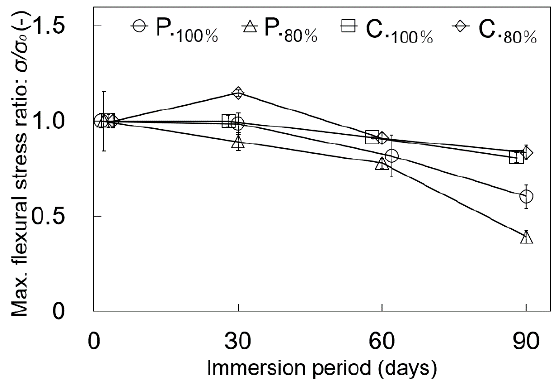
Figure 11. Comparison of the changes of the maximum flexural stresses of the four test piece types brought about by the immersion. Average ± S.D., N = 5.